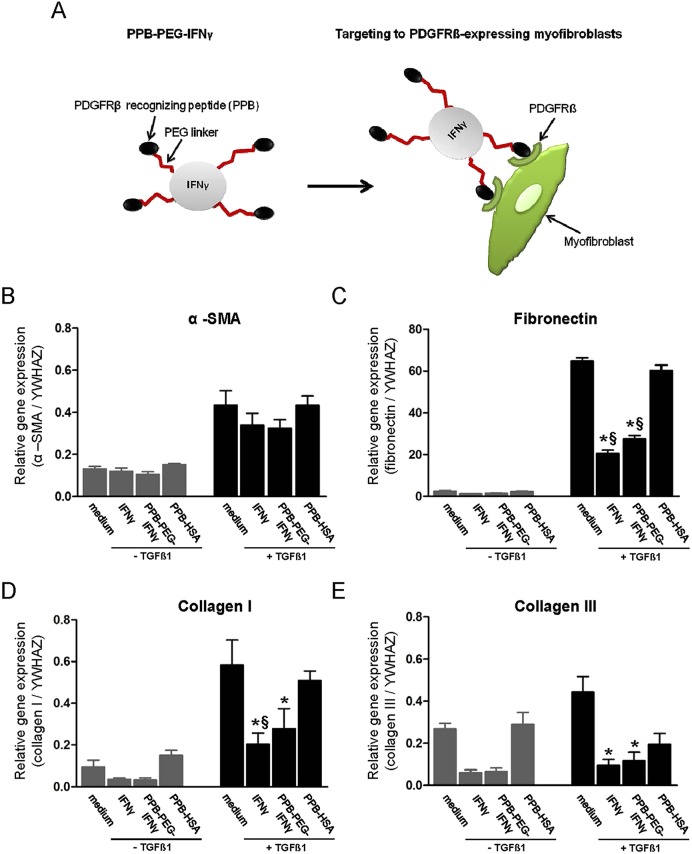
Effect of IFNγ and PPB-PEG-IFNγ on the expression of fibrotic markers in mPCKS. (A) Schematic of targeted delivery of IFNγ to PDGFRβ-expressing myofibroblasts in mPCKS. Relative gene expression of (B) α-SMA, (C) collagen I, (D) fibronectin and (E) collagen III. *P<0.05 versus medium; §P<0.05 versus PPB-HSA.